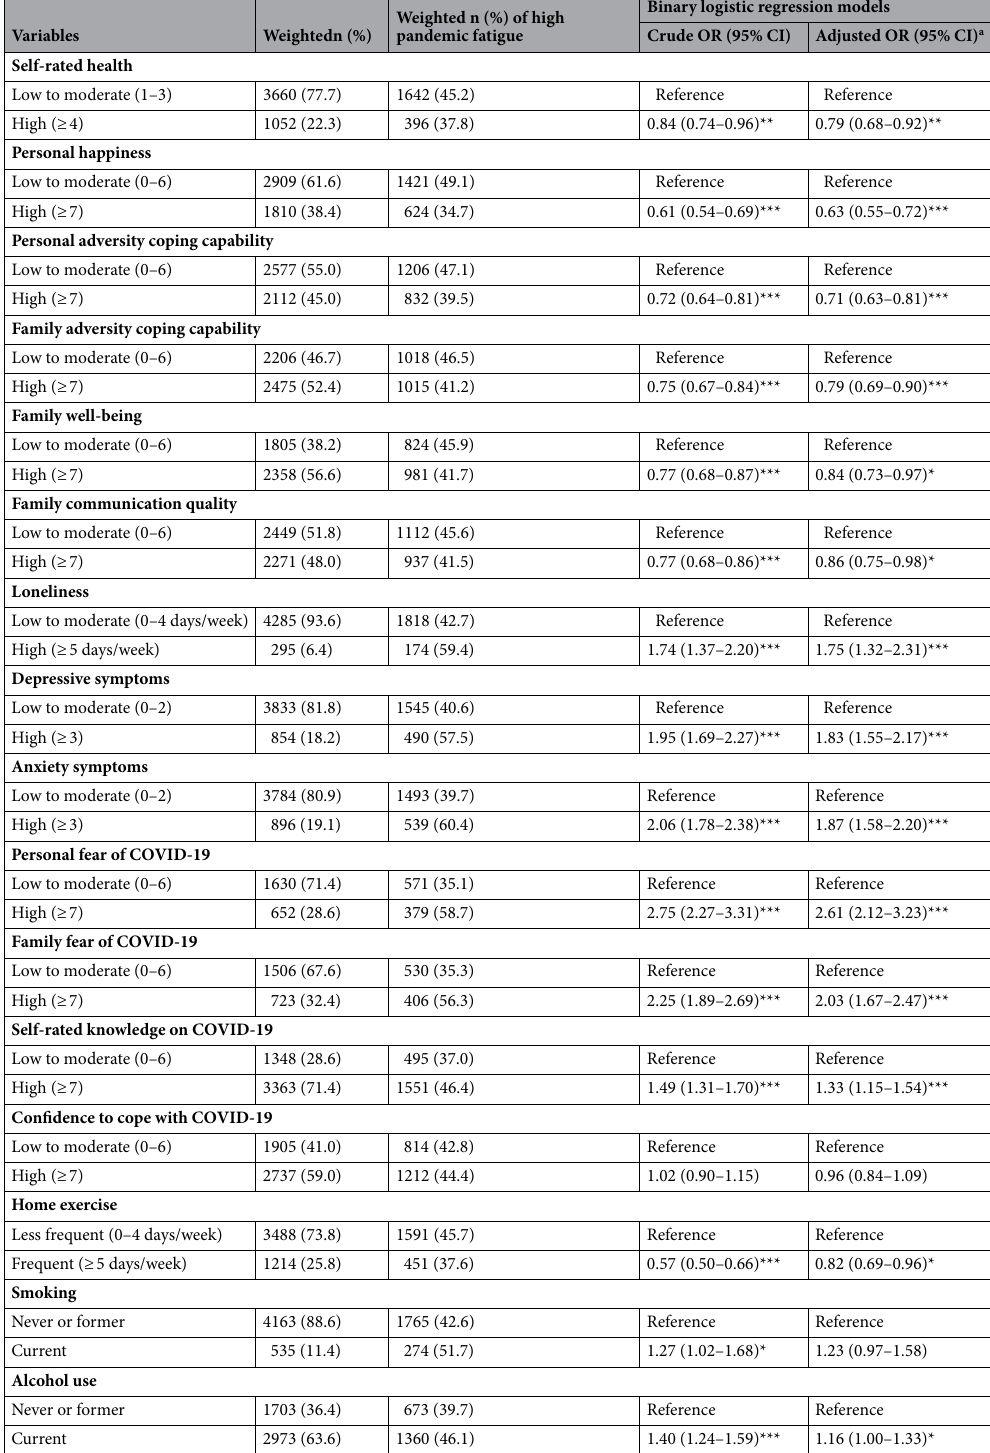
Table 2. Associations between high pandemic fatigue and psycho-behavioral variables. a . OR adjusted for all sociodemographic variables. Missing data were excluded. Weighting was applied based on the distribution of sex, age, and education in the Hong Kong population 2020 census data. * P < 0.05, ** P < 0.01 *** P <